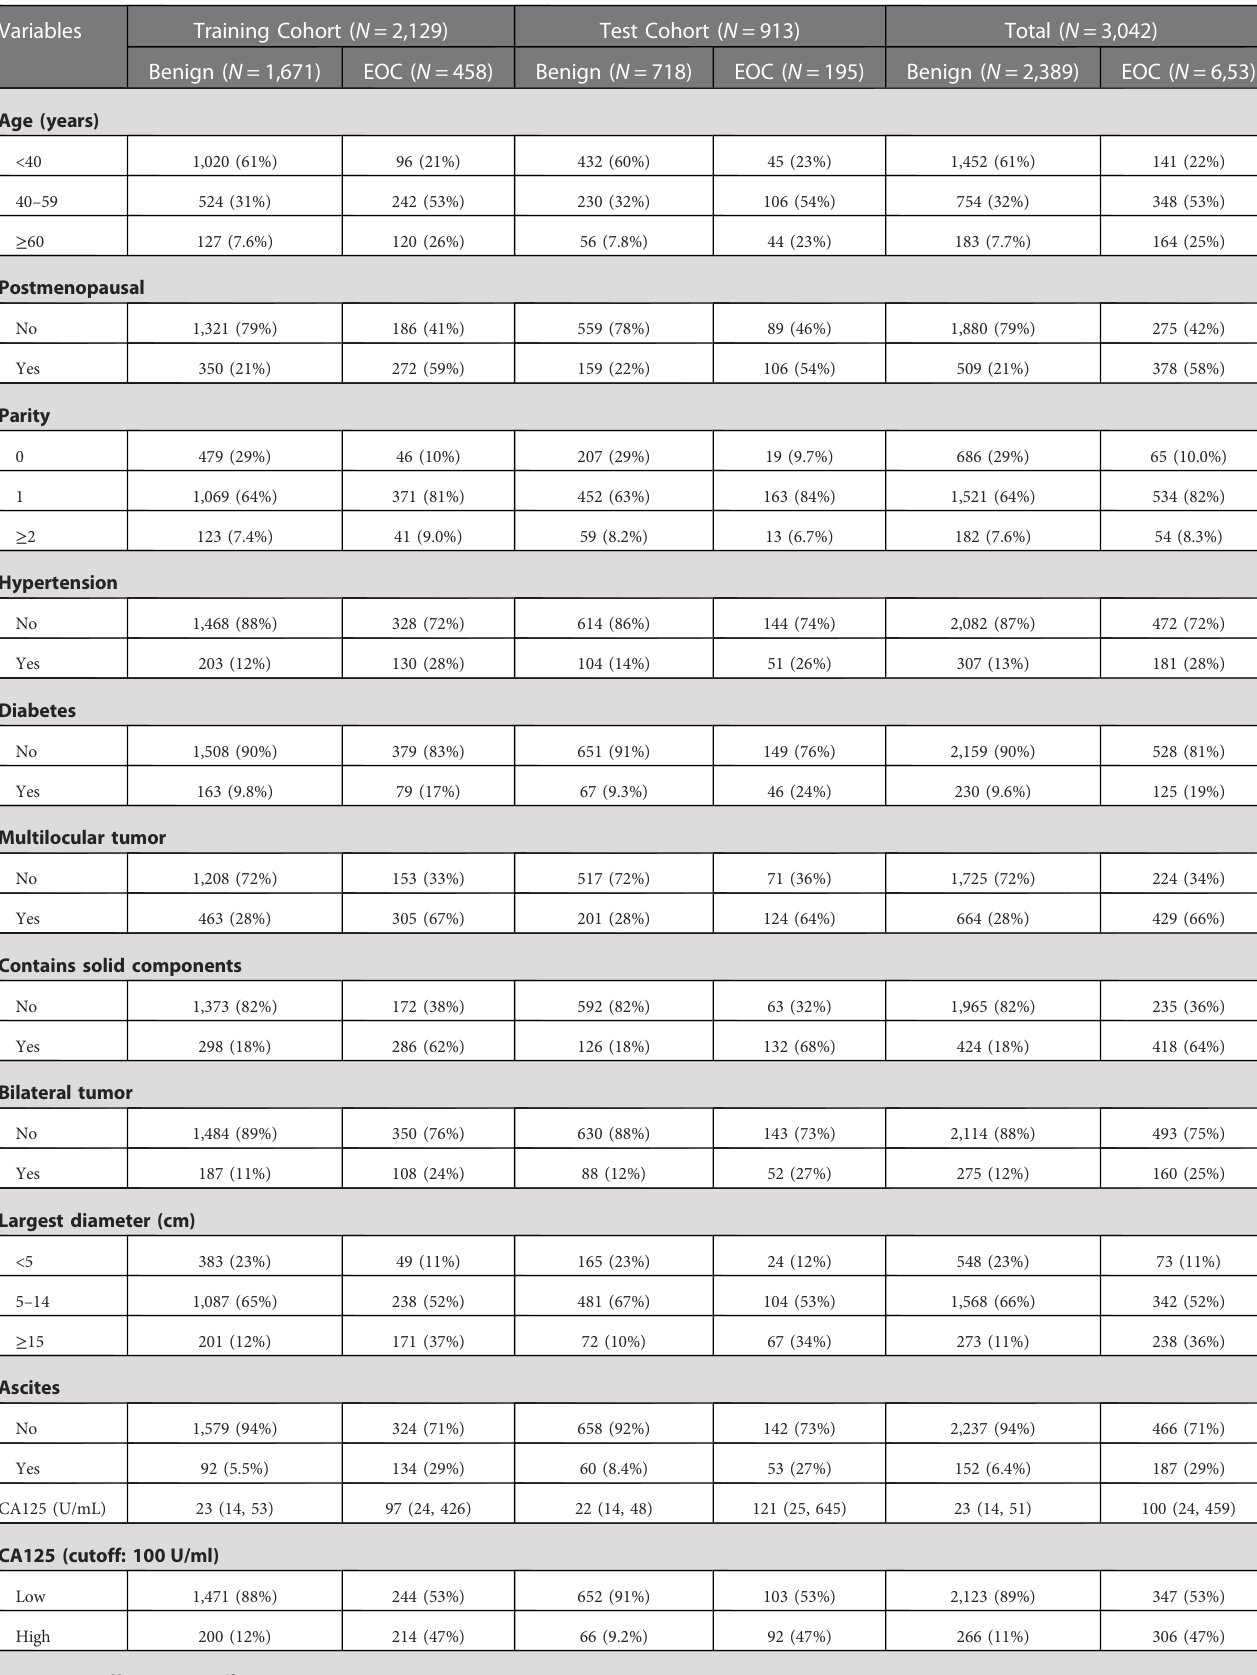
TABLE 1 Patients ’